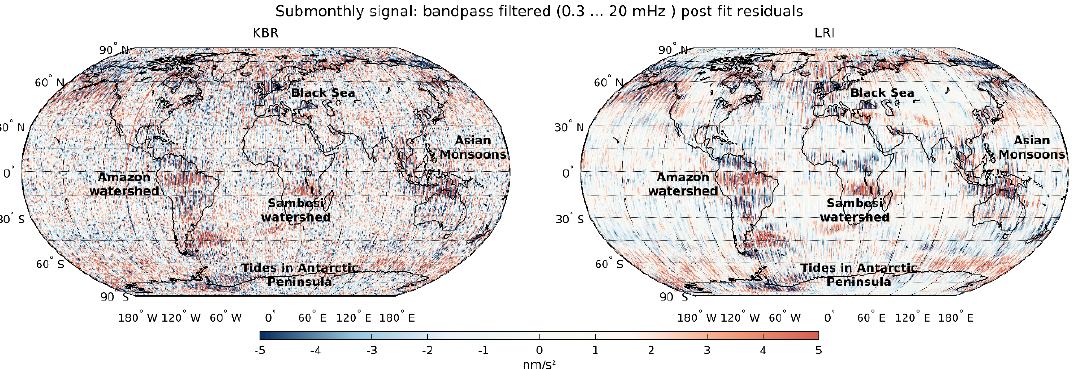
Figure 1. The time derivative of range-rate post-fit residuals describe signals that cannot be explained with a monthly gravity field map, i.e., sub-monthly gravity variations, instrument noise (accelerometer, ranging instrument and others) and background model deficiencies. The left plot shows microwave-based residuals, which are more noisy compared to the LRI observations on the right side. The map is based on GRACE-FO data from January 2019. This figure illustrates that laser interferometry can help to resolve short-term mass variations over land, which are currently not part of monthly gravity field maps. (credit: Markus Hauk GFZ/AEI).